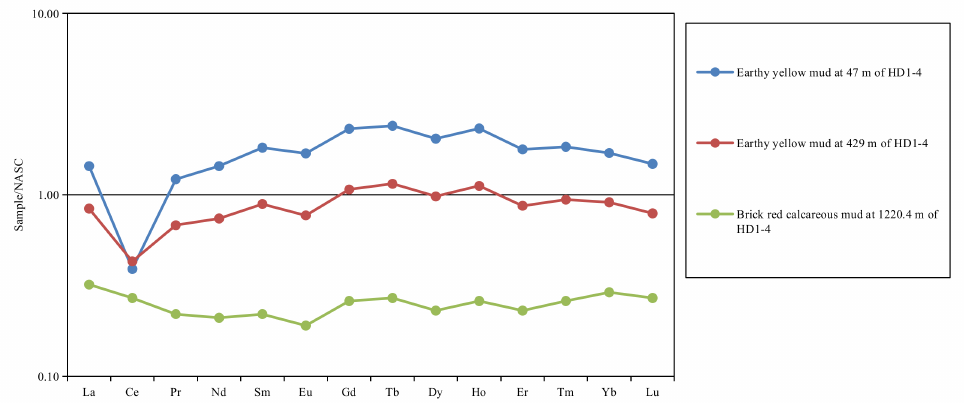
Figure 8. REE distribution pattern of mud filled at different depths of HD1-4. NASC = The REE value of North American shale as the standard value; REE = Rare earth